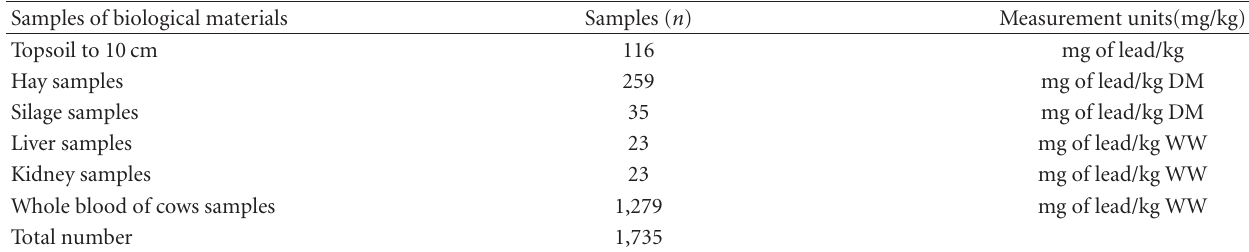
Table 1: The examined biological material, total number of samples ( n = 1,734), and measurements units from 1975 to 2002 on farms ( n = 1 to 14) around the mine area and smelter in the Upper Meˇza Valley.